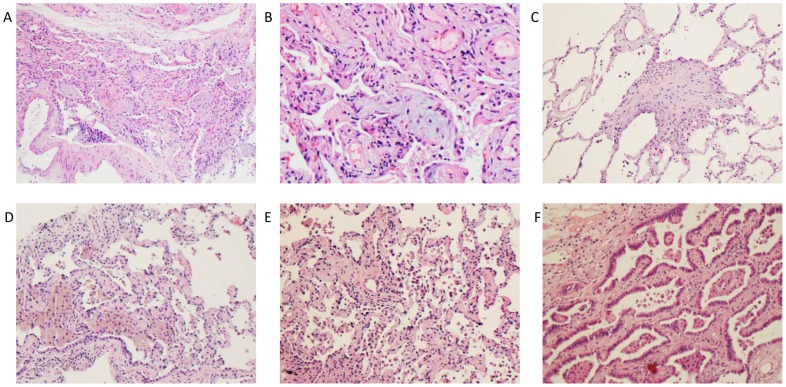
Bronchoscopic cryobiopsy identifies characteristic histopathology from multiple DPLDs.Representative hematoxylin and eosin stained cryobiopsies from subjects with cryptogenic organizing pneumonia (A) 100x and (B) 400×, (C) bronchiolitis obliterans (200×), (D–E) respiratory bronchiolitis-interstial lung disease/desquamative interstitial pneumonia(100×) and (F) adenocarcinoma with lepidic spread, previously bronchoalveolar cell carcinoma (100×). Power reported as original magnification.